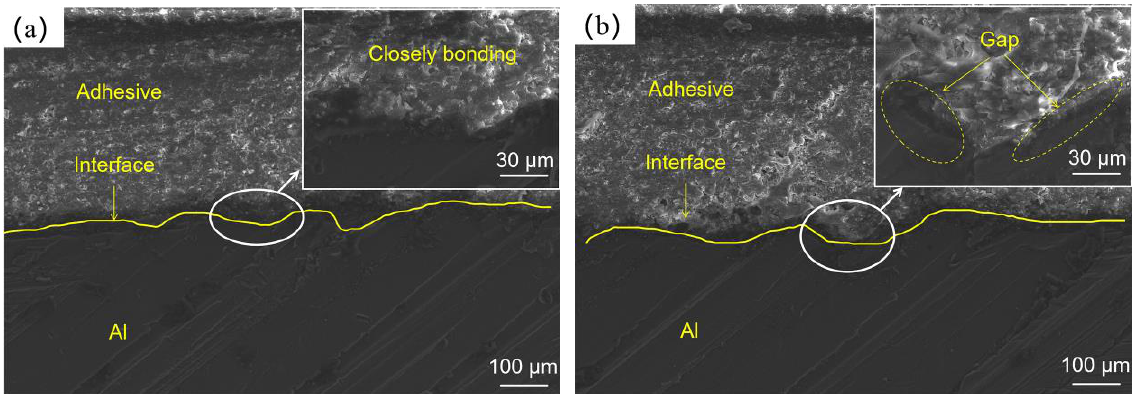
Figure 9. Micro-failure morphology of joints under different load levels: ( a , b ) [0/90] 4s , ( c , d )